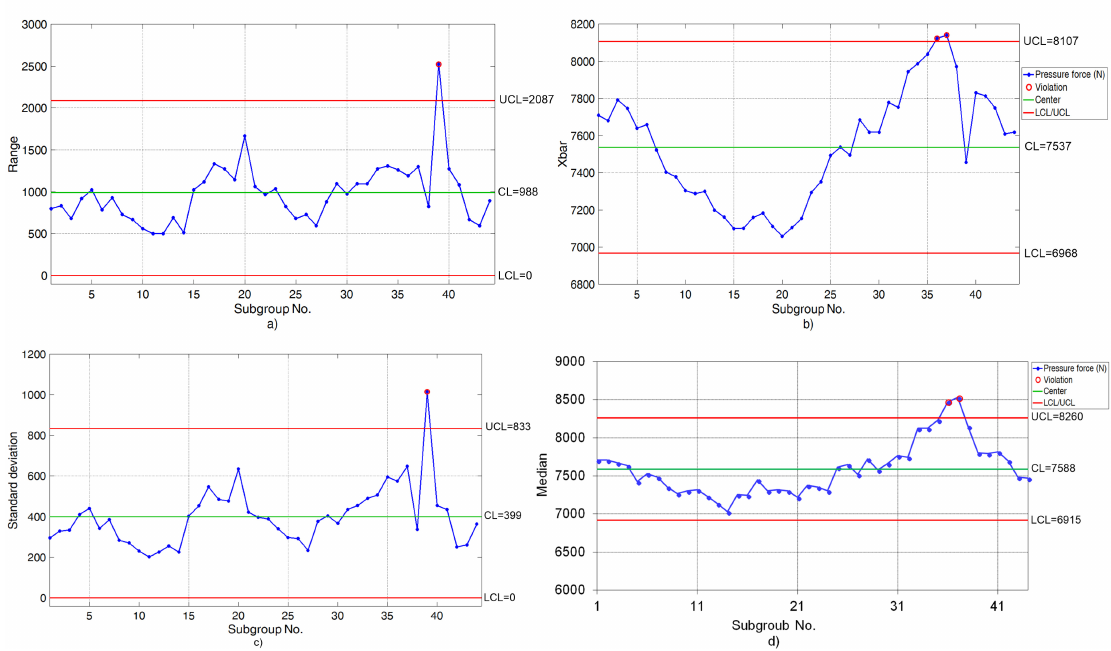
Figure 12. Control charts for technological parameter pressure force ( a ) diagram of variation range, ( b ) diagram of arithmetic mean, ( c ) diagram of standard deviation, ( d ) diagram of the median. The following values were obtained from the control charts for the moving range ¯ R MR , individual values X ., moving averages ¯ X MA : the value of the center line and the control limits of the sliding range for the pressure are CL = 411, UCL = 870, LCL = 0 (see Figure 13a); for individual values they are CL = 7547, UCL = 8078, LCL = 7015 (see Figure 13b) and for moving averages they are CL = 7546, UCL = 7784, LCL = 7309 (see Figure 13c).